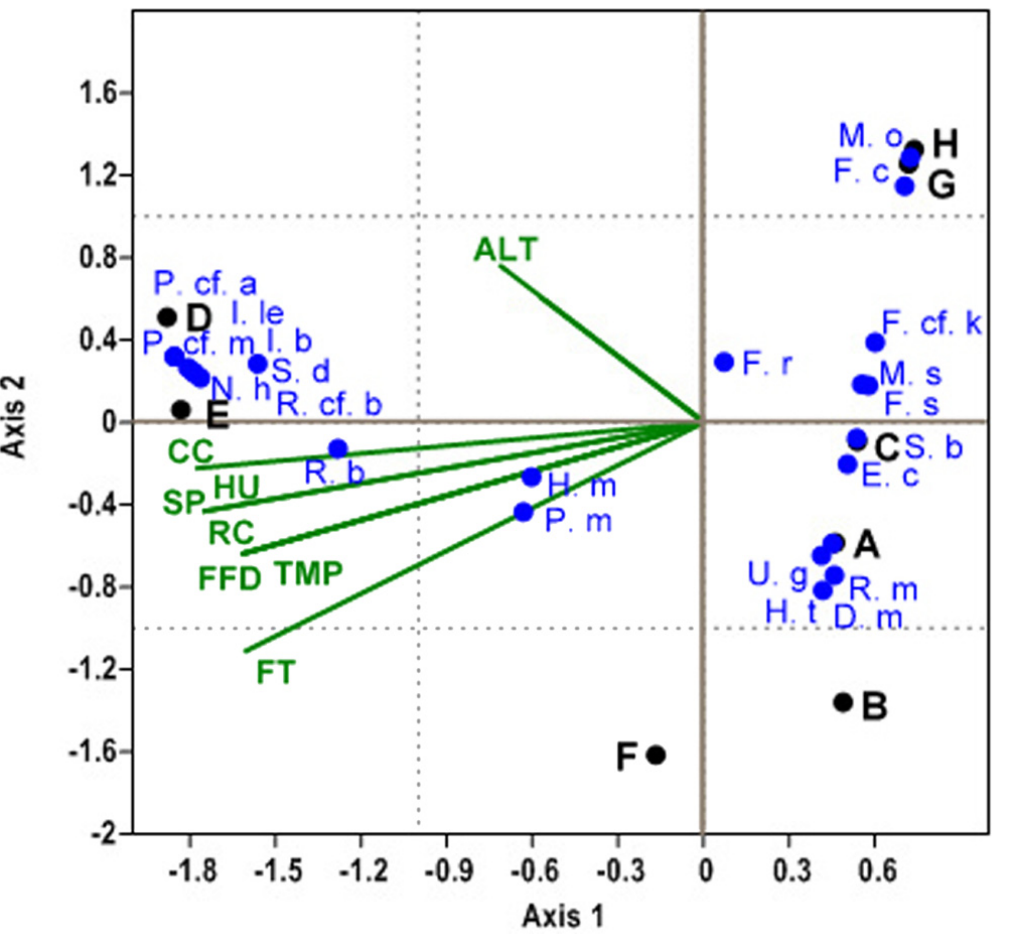
Figure 4. Canonical Correspondence Analysis (CCA) ordination triplot showing anuran species distribution with reference to study sites and habitat variables. Site labels are coded in Figure 1. habitat variable codes: AlT – altitude; CC – canopy coverage; RC – riparian canopy coverage; hU – humidity; SP – stream persistence; FFD – forest floor litter depth; TMP – temperature; FT – forest type. Species codes: D. m - Duttaphrynus melanostictus ; E. c - Euphlyctis cyanophlyctis ; F. cf. k - Fejervarya cf. keralensis ; F. c - Fejervarya caperata ; F. r - Fejervarya rufescens , F. s - Fejervarya syhadrensis , h. t - Hoplobatrachus tigerinus ; M. s - Minervarya sahyadris ; S. b - Sphaerotheca breviceps ; S. d - Sphaerotheca dobsonii ; M. o - Microhyla ornata ; R. m - Ramanella mormorata ; U. g - Uperodon globulosus ; N. h - Nyctibatrachus humayuni